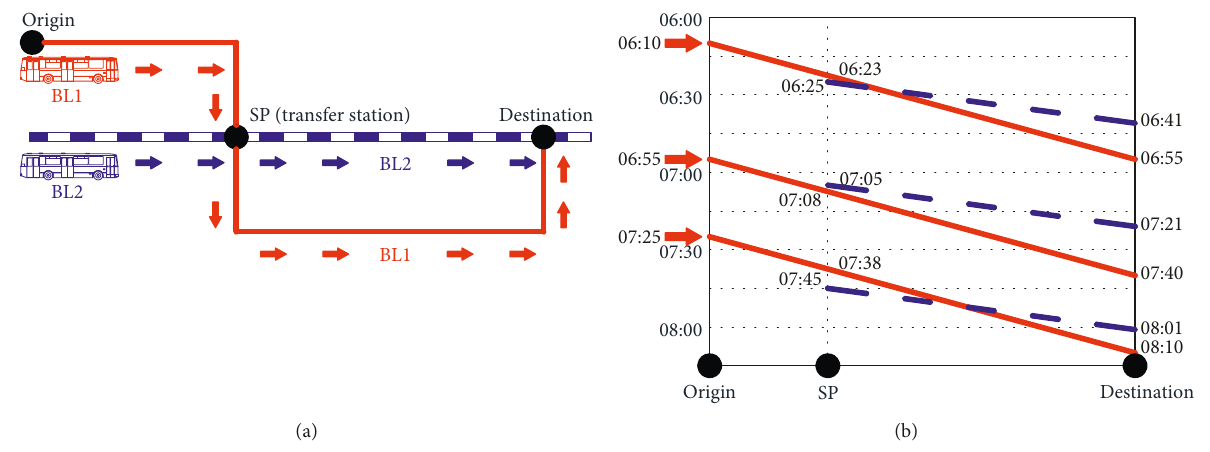
Figure 1: An example of (a) bus network and (b) graphical